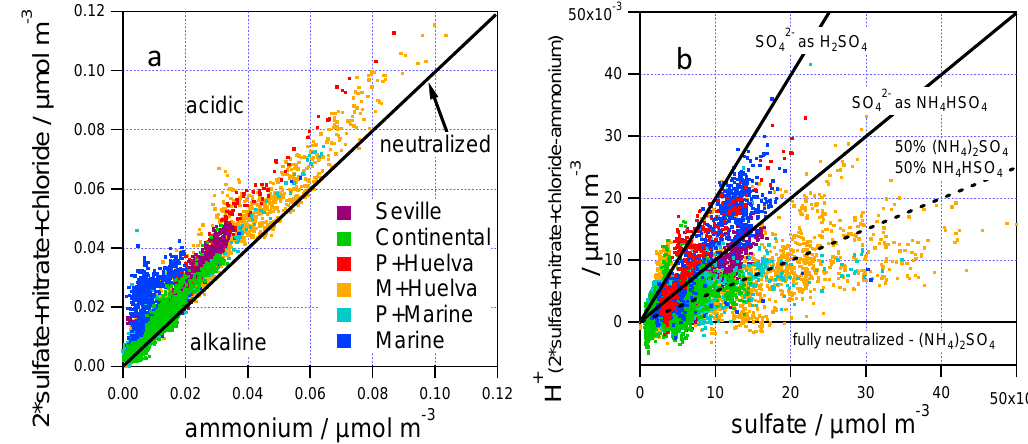
Fig. 8. Correlations illustrating the difference of the ion balance (a) dependent on the air mass origin. The scatter plot (b) serves for the identification of the sulfur species ammonium sulfate ((NH 4 ) 2 SO 4 ) , ammonium bisulfate (NH 4 HSO 4 ) and sulfuric acid (H 2 SO 4 ) within the different aerosols. Points represent 2min average